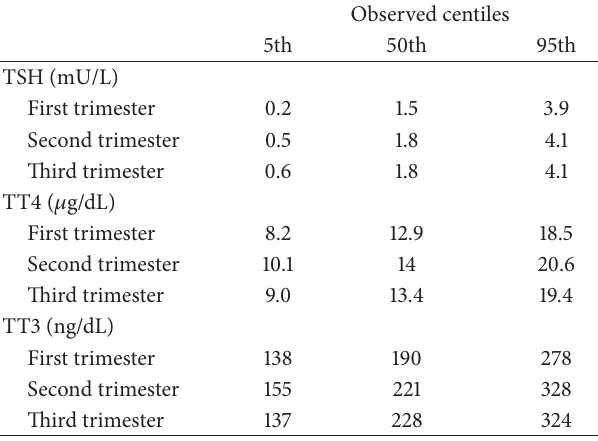
Mean ± SD, † median values (inter quartile range). Table 2: Gestation specific percentile values for TSH, TT4, and TT3 in a self sequential cohort of 152 pregnant women with normal singleton pregnancies.